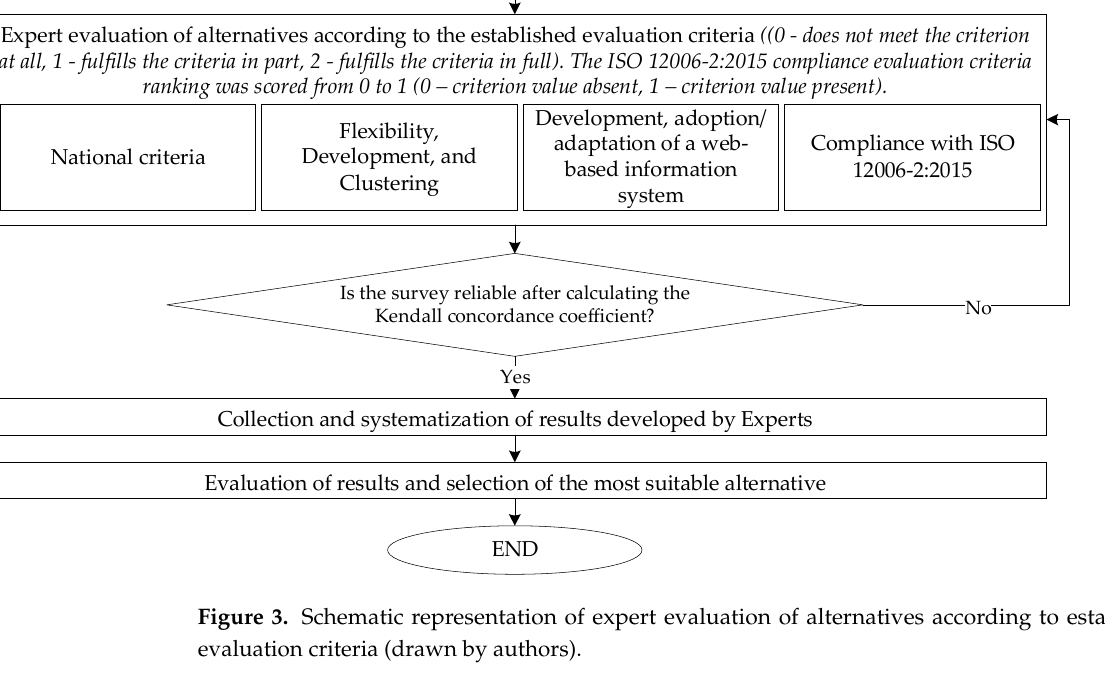
Table 7. National evaluation criteria for NCICS alternatives, their ranking in importance order, and compliance with alternatives. Group Rank National Evaluation Criteria for NCICS Al- ternatives